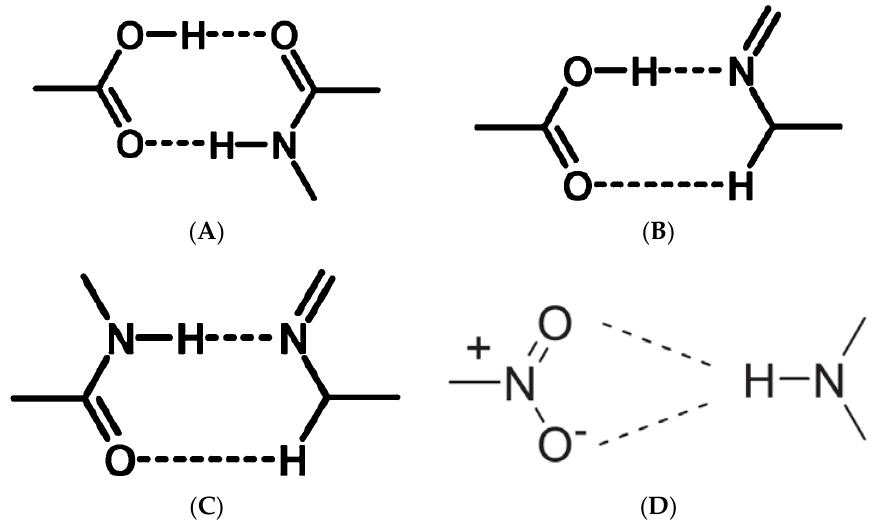
Figure 6. Schematic representation of supramolecular heterosynthons ( A ) acid-amide dimer [29,50], ( B ) acid-pyridine dimer [34,55], ( C ) amide-pyridine dimer [34,55] [Reprinted from [55] with permission. Copyright 2014 American Chemical Society] and ( D ) Nitro-amine interaction [98] [Reprinted from [98] with permission from Elsevier].